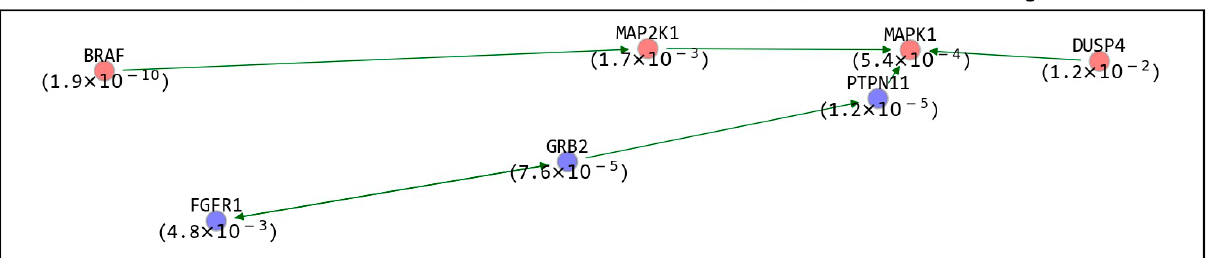
Figure 4. SPN2 and SPN1 for mutated BRAF in KEGG networks from CRISPR screening. The red and blue nodes are the SPs associated with GIs sensitive and resistant to mutated BRAF , respectively. The gray nodes are not SPs but genes connecting SPs of mutated BRAF . SPN2 includes the SPs that are connected to each other within a distance of 2, and SPN1 includes the SPs that adjoin each other. The number in parentheses for each SP indicates its FDR. SPN: synthetic partner network.